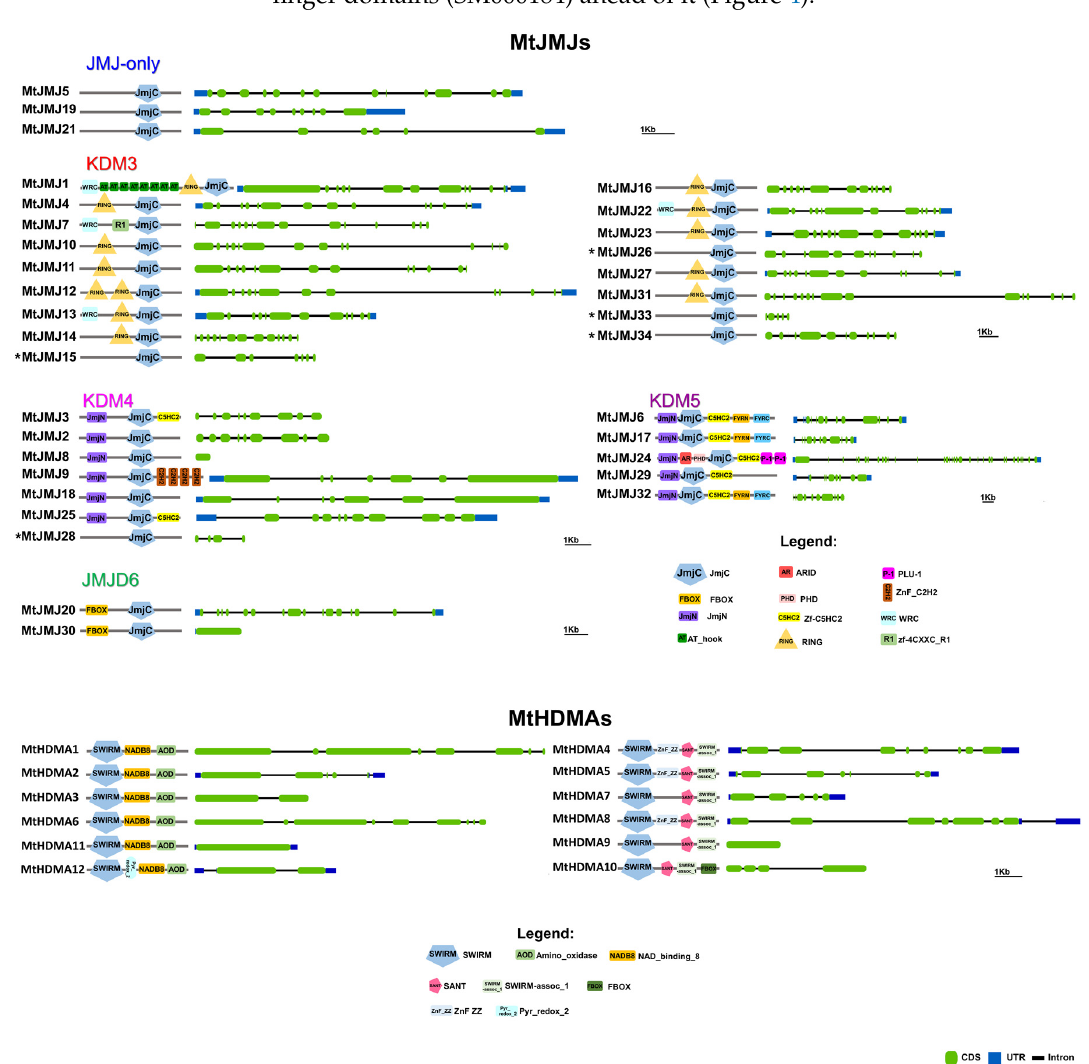
Figure 4. The domain composition and intron-exon structure of M. truncatula HDMs. MtJMJs that are indicated with an asterisk belong to the JMJ-only class, based on domain composition, but were put close to their relatives based on phylogenetic analysis to better compare the intron-exon